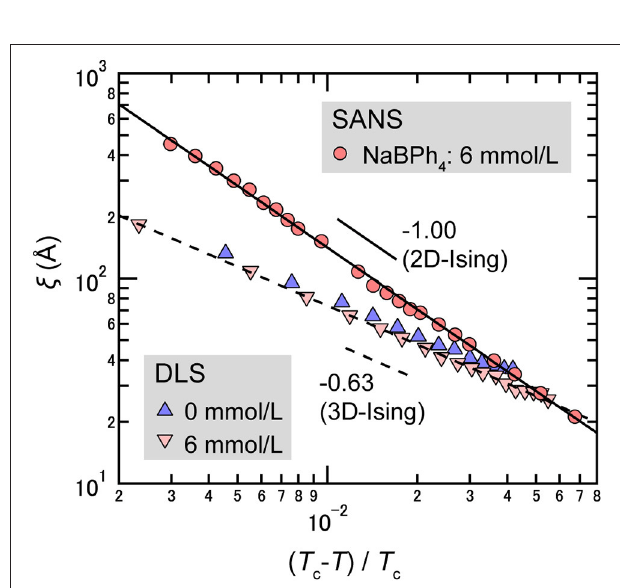
FIGURE 12 | Temperature dependence of ξ for mixtures of D 2 O/3MP ( φ 3MP = 0.35) and D 2 O/3MP/NaBPh 4 ( φ 3MP = 0.35 and C salt = 85 mmol/L). The circles are data obtained by SANS measurements [22], while the triangles and the inverted triangles are data obtained by DLS measurements